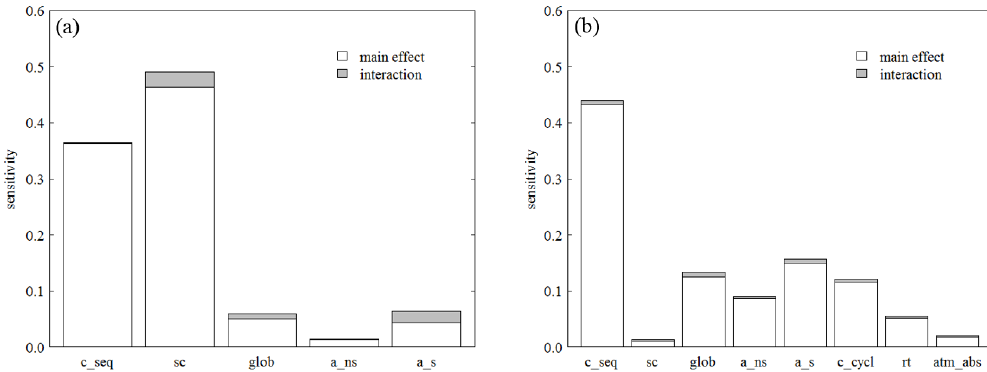
Figure 6. Global sensitivity analysis FAST: (a) sensitivity analysis of spatial variability of c seq (carbon sequestration), s c (snow cover), glob (global radiation), a ns (albedo difference no snow cover) and a s (albedo difference snow covered), (b) sensitivity analysis of uncertainty for each pixel: c seq , sc , glob, a ns , a s , c cycle (carbon cycle), r t (radiative transfer) and atm absorb (atmospheric